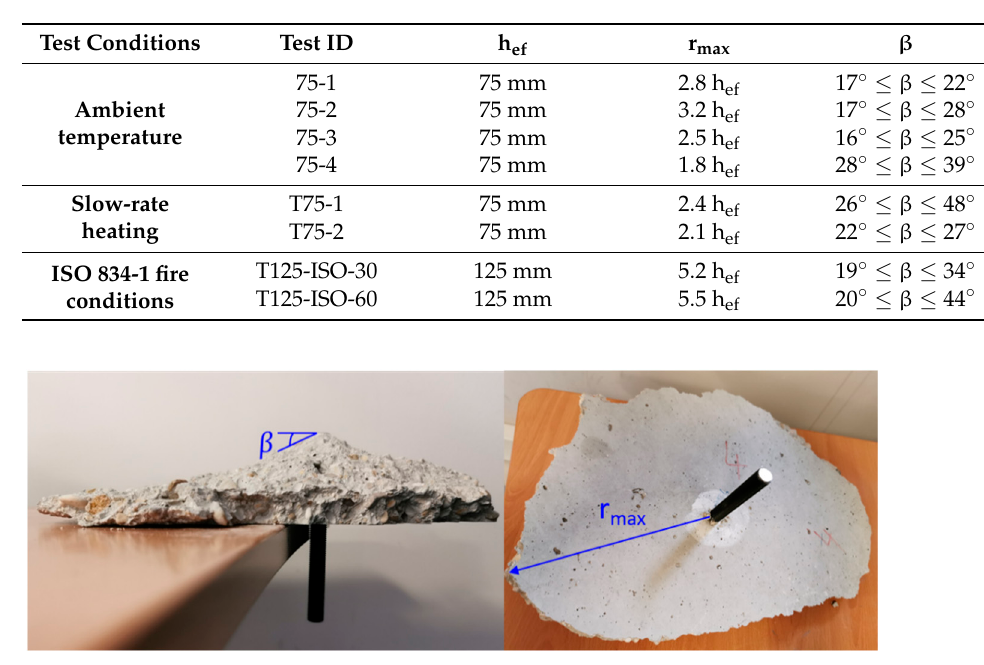
Figure 10. Failure angle and maximum radius of the concrete cone. Table 3. Geometrical characteristics of the concrete cones.